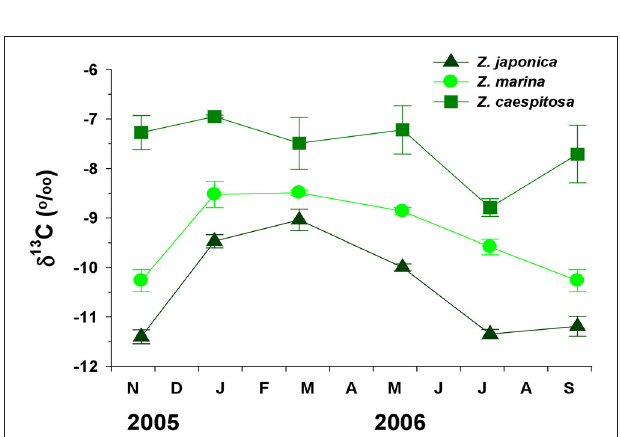
FIGURE 7 | Three Zostera species ( Z. japonica , Z. marina , and Z. caespitosa ). Seasonal variations in carbon stable isotope ( δ 13 C) values at Koje Bay. Values are expressed as mean ± SE ( n =